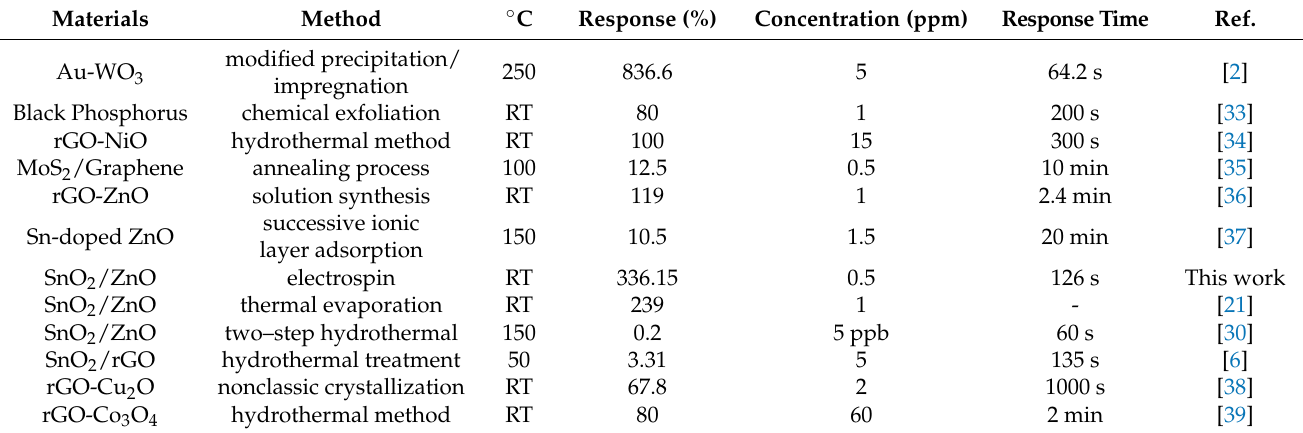
Figure 6. ( a ) Dynamic response curves to 0.1–20 ppm NO 2 gas at room temperature. ( b ) The linear range for NO 2 detection of SnO 2 /ZnO-3 gas sensors. ( c ) Response and recovery time of SnO 2 /ZnO-3 gas sensors to 0.5 ppm NO 2 . ( d ) Response and recovery time of gas sensors based on as-prepared samples to 0.5 ppm NO 2 . Table 2. Comparison of the NO 2 sensing properties of different materials.